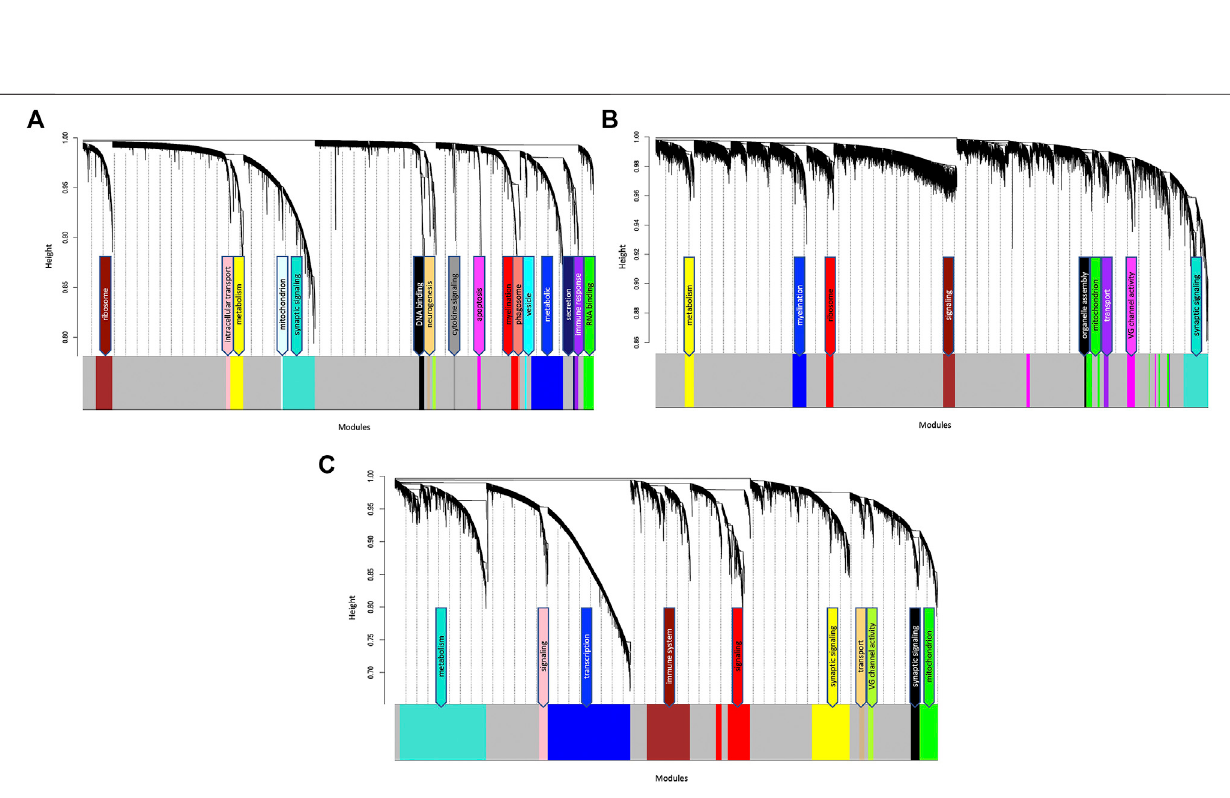
Frontiers in Genetics |